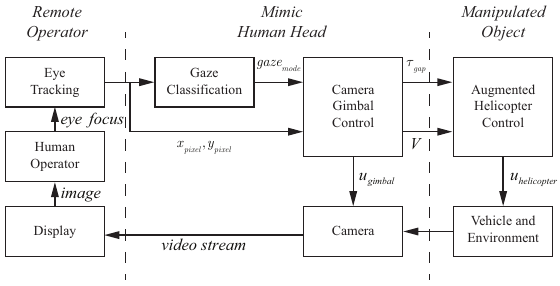
Figure 21. Components of the gimbal control